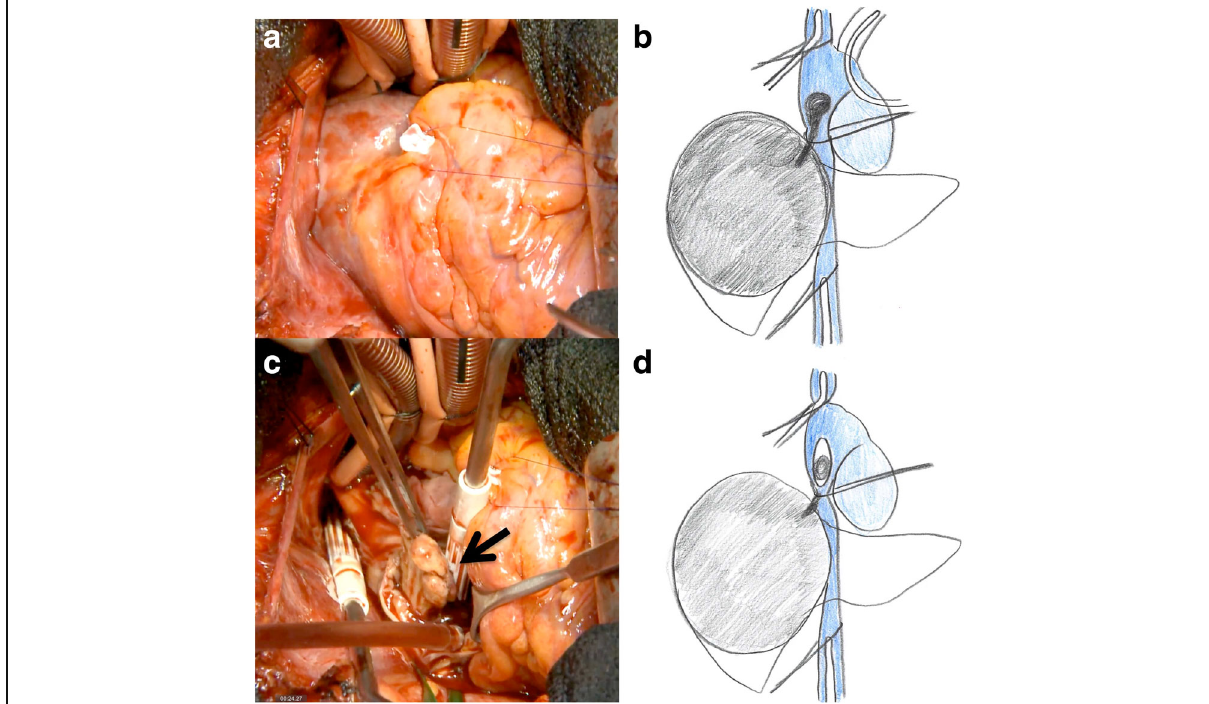
Fig. 3 Tumor thrombectomy in the right atrium under electrical ventricular fibrillation and cardiopulmonary bypass (CPB) was performed after intravenous injection of heparin sodium ( a , b ). The TT in the right atrium was removed from the right atrium without pulmonary embolization ( c , d ). The open heart surgery time was 23